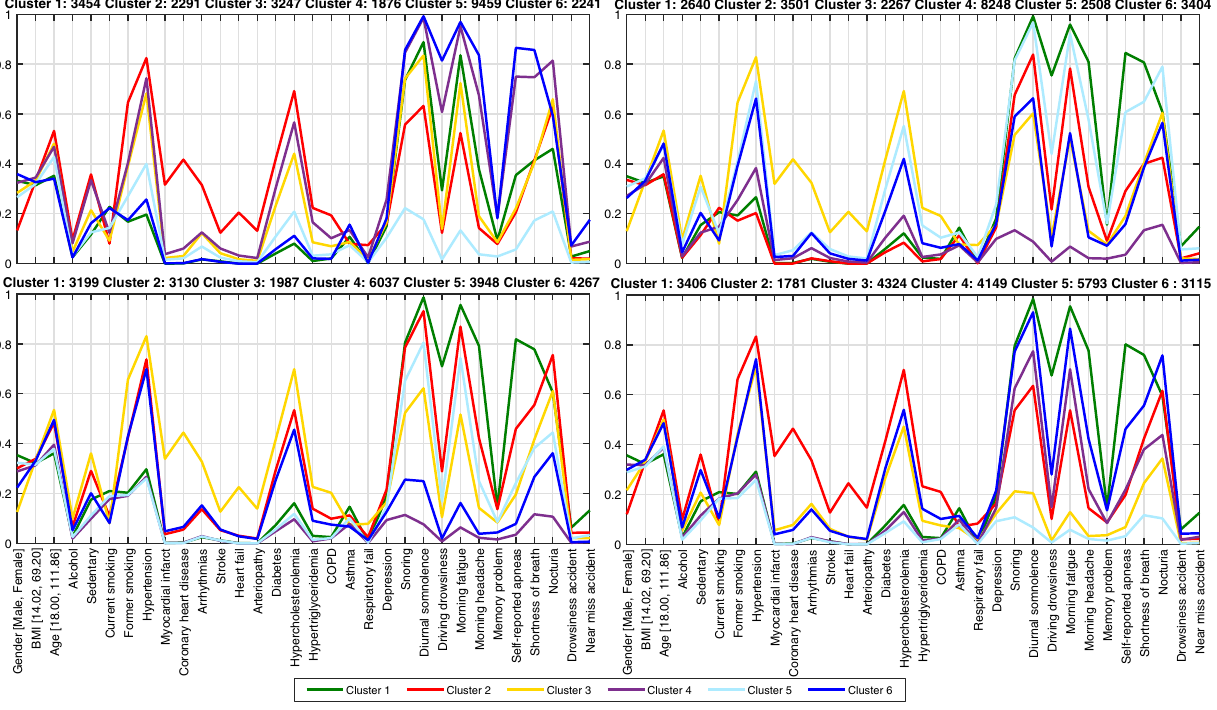
Fig. 17 The centers of clusters of Snapshot 2–5 (top left to bottom right). The y -coord shows the percentage of patients in a group with a specific symptom or comorbidity, except for gender (percentage of female), BMI and age (normalized into [0,1]) (best view in colors)